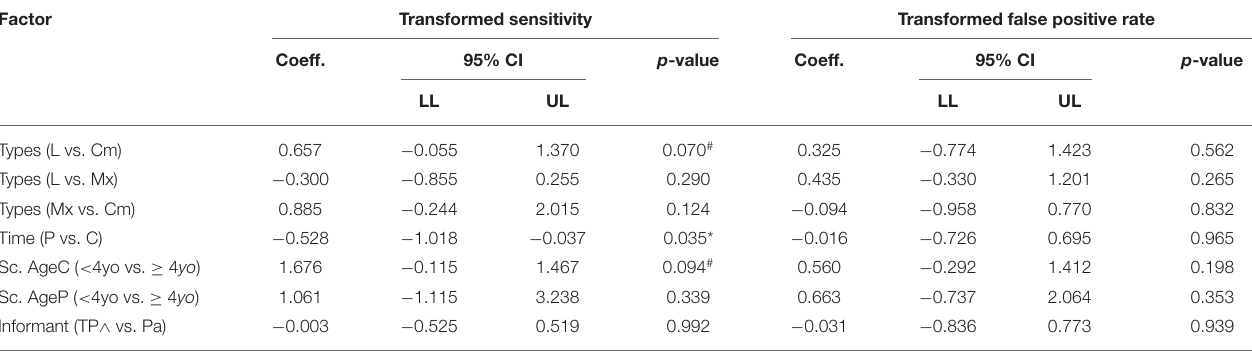
TABLE 7 | Bivariate meta-regression on studies-related factors on sensitivity and false-positive rate. Factor Transformed sensitivity Transformed false positive rate Coeff. 95% CI p -value Coeff. 95% CI p -value